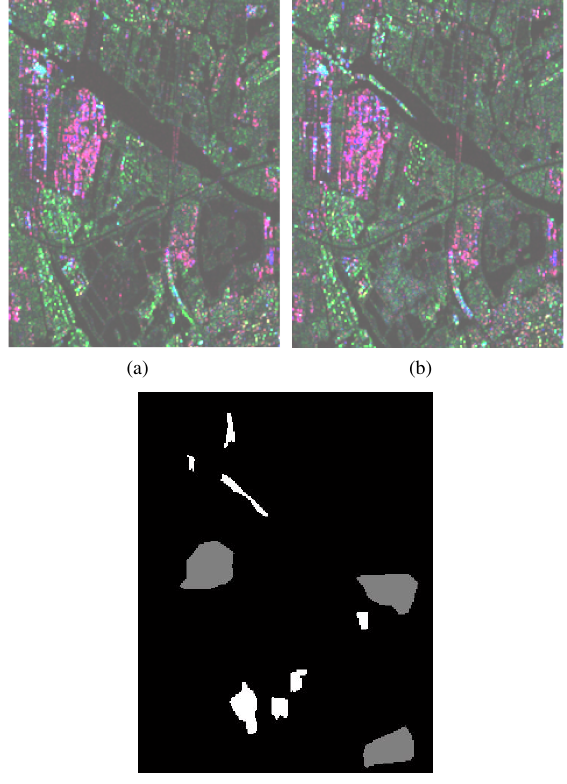
(c) Figure 2: Multitemporal PolSAR images relating to the city of Suzhou used in this experiment. (a) April 9, 2009 pauli decom- position image. (b) June 15, 2010 Pauli decomposition image. (c) Map of changed areas (ground truth) used as reference in the ex- periment. Color legend for (c): white, change; gray, no-change; black, unlabeled